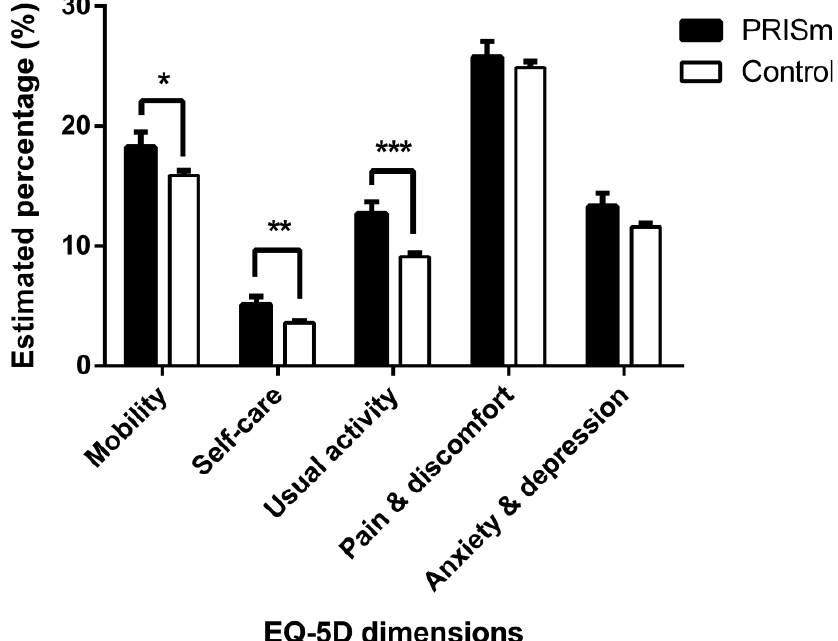
Figure 3. Dissatisfaction with health-related quality of life dimensions according to the Euro Quality of Life-5D (EQ-5D). Note: * p < 0.05, ** p < 0.01, *** p < 0.001.